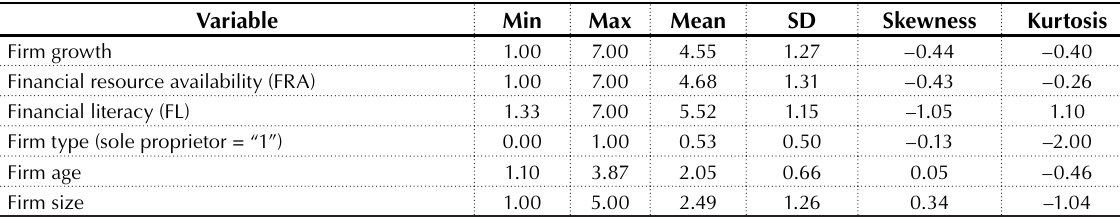
Table 2. Descriptive statistics of the study constructs